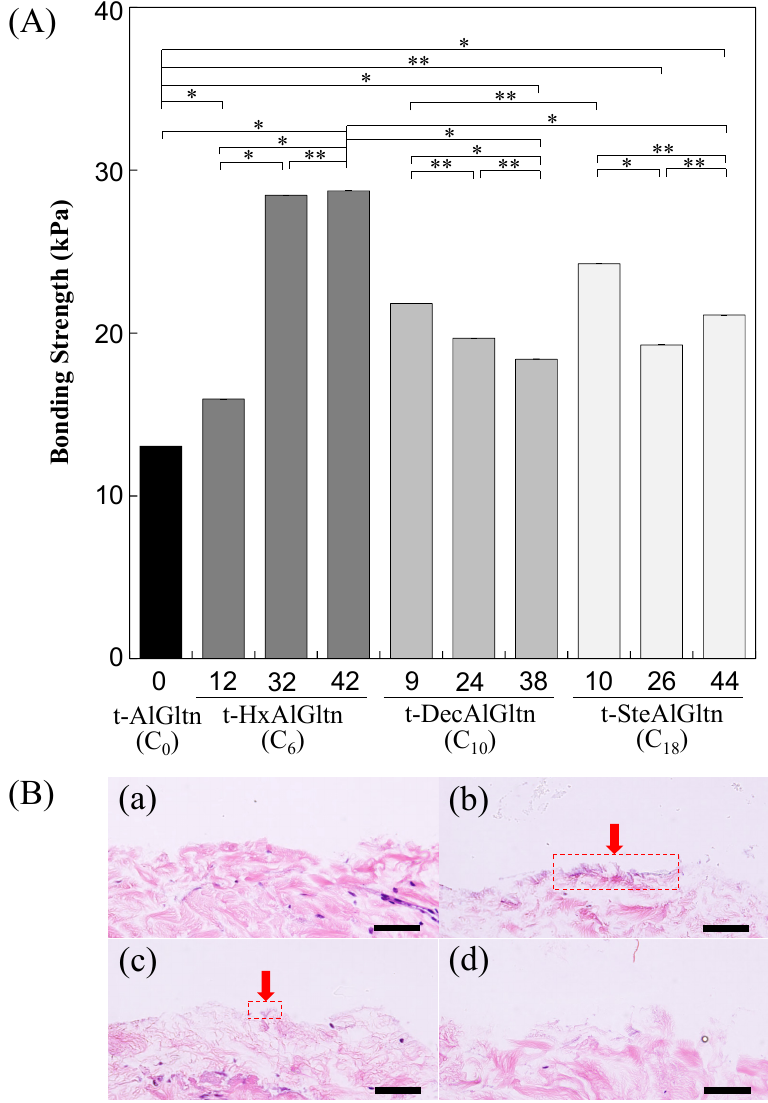
Figure 4. Bonding strength of t-hm-AlGltn films on the porcine blood vessel. ( A ) Effect of chain length and density of hm-AlGltns on the bonding strength. Data are shown as the average ± S.D. of three samples (* p < 0.05, ** p ≥ 0.05); ( B ) Cross-sectional views of the film-tissue interface after bonding strength measurement of ( a ) t-AlGltn; ( b ) t-42HxAlGltn; ( c ) t-38DecAlGltn; and ( d ) t-44SteAlGltn. Scale bar: 50 µm. Red arrows show the sites t-hm-AlGltn